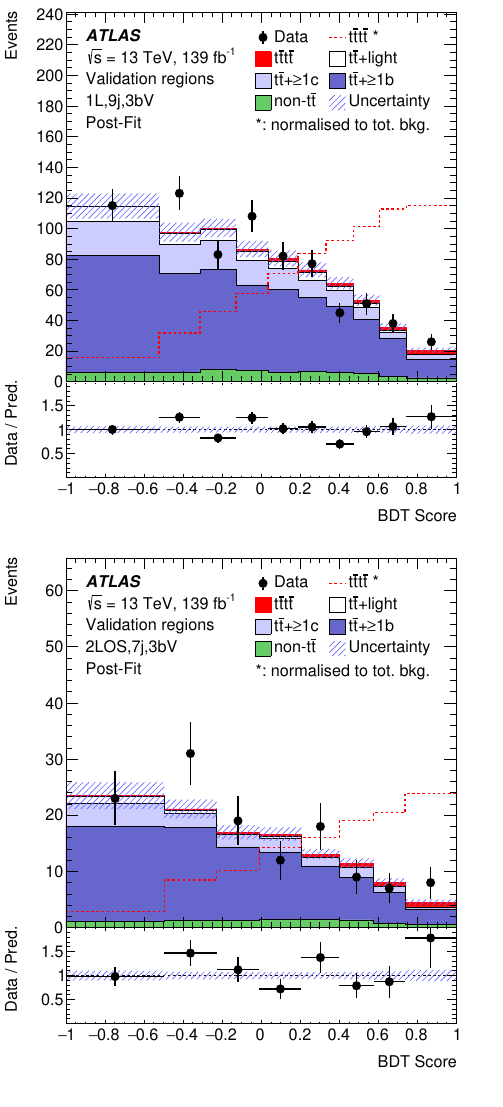
Figure 9 . Comparison between data and post-fit prediction for the distributions of the BDT score in each validation region. The band includes the total uncertainty of the post-fit computation. The dashed red line shows the signal distribution normalised to the background yield. The ratio of the data to the total post-fit computation is shown in the lower